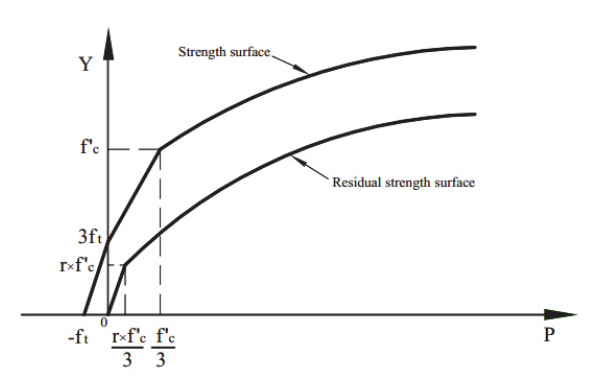
Figure 3: Strength surface of concrete